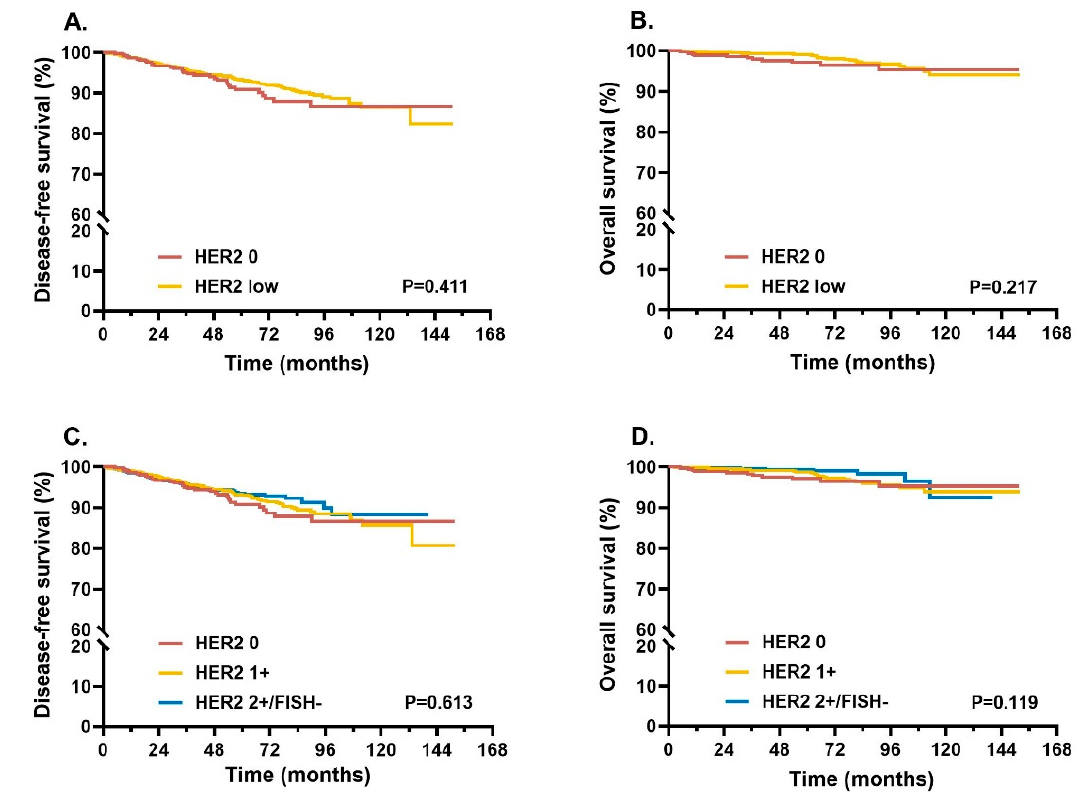
Figure 4. Survival in different HER2 IHC/FISH status patients. Kaplan–Meier curves of DFS ( A ) and OS ( B ) were compared between HER2 0 and HER2-low patients. Further comparisons of DFS ( C ) and OS ( D ) were performed in HER2 0, HER2 1+, and HER2 2+/FISH − patients. p -values for log-rank tests were reported at the bottom of each box. Abbreviations: HER2, human epidermal growth factor receptor 2; IHC, immunohistochemistry; FISH, fluorescence in situ hybridization; DFS, disease-free survival; OS, overall survival.